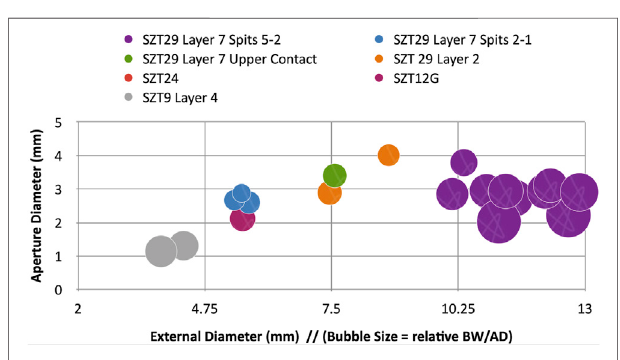
FIGURE 7 | Bubble chart plotting three variables to visually compare Shizitan OES ornament data: external diameter (mm; x-axis), aperture diameter (mm; y-axis), and the relative “ display area ” (body width/aperture diameter ratio), indicated by the size of the bubble. Colors indicate Shizitan contexts. Plotted ornaments must have all three values available; see Table 2 for values. Note the large display area (bubble size) despite the small external diameter for the latest (Phase 4) ornaments, from SZT